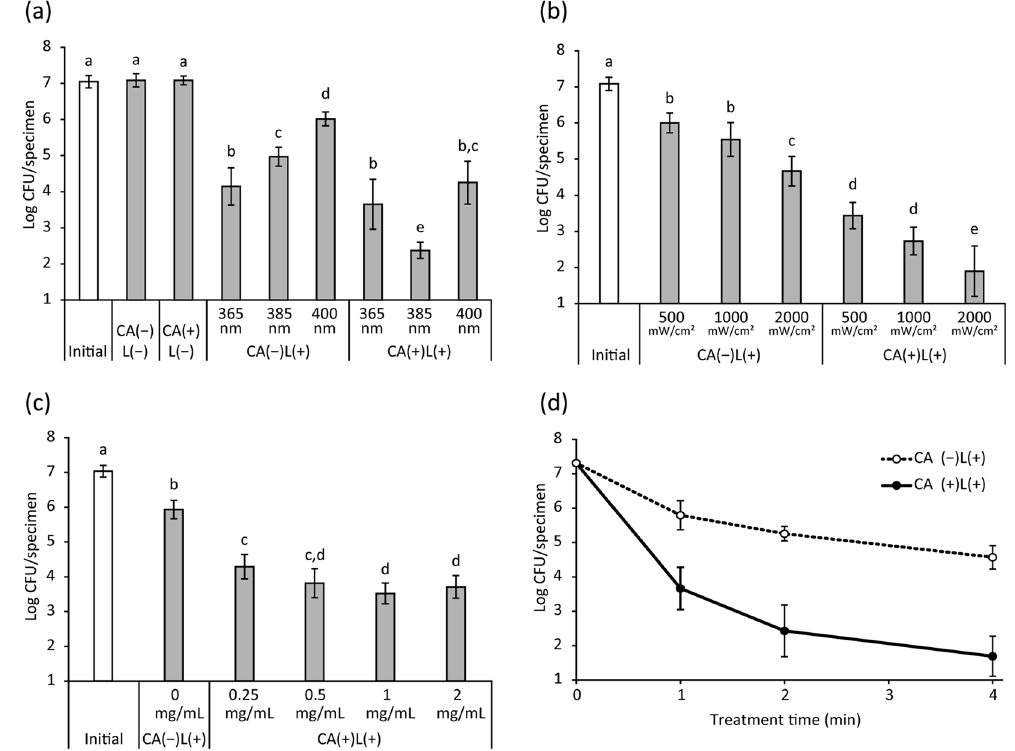
Figure 1. Bactericidal activity of a photo-irradiated caffeic acid (CA) solution against Streptococcus mutans biofilms. The bacteria in the biofilm were collected after each treatment by swabbing, and were suspended in saline. The number of bacteria in the suspension was determined by standard plate counting. ( a ) Wavelength- dependent bactericidal activity (irradiance: 1000 mW/cm 2 , concentration of CA: 1 mg/mL, treatment time: 4 min), ( b ) irradiance-dependent bactericidal activity (wavelength: 385 nm, concentration of CA: 1 mg/mL, treatment time: 4 min), ( c ) concentration-dependent bactericidal activity (wavelength: 385 nm, irradiance: 2000 mW/cm 2 , treatment time: 1 min), and ( d ) time-dependent bactericidal activity (wavelength: 385 nm, irradiance: 2000 mW/cm 2 , concentration of CA: 1 mg/mL). Values and error bars indicate the mean and standard deviation, respectively. Different letters above the columns in ( a ), ( b ), and ( c ) refer to significant differences ( p < 0.05) between different groups. CA( − )L( − ): Treatment with pure water in a light-shielding box, CA( + ) L( − ): Treatment with CA in a light-shielding box, CA( − )L( + ): LED irradiation of sample in pure water, CA( + ) L( + ): LED irradiation of sample in